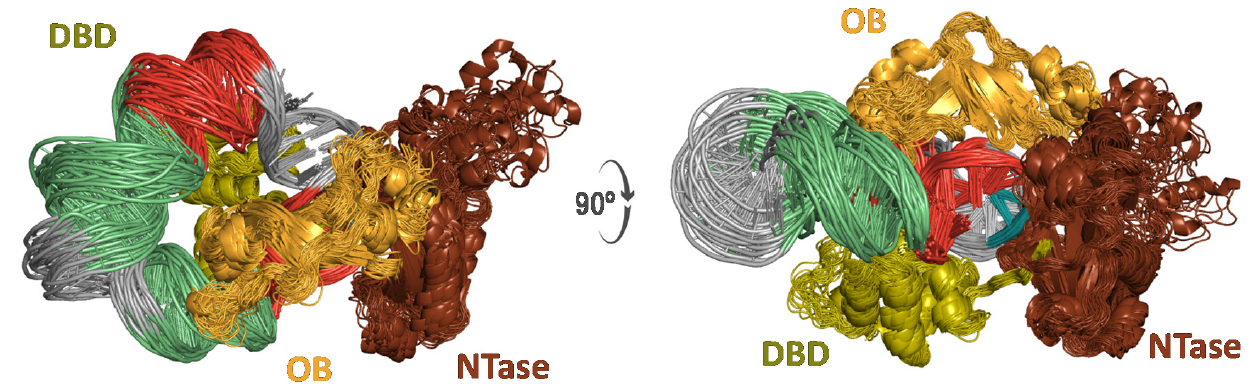
Figure 5. Cartoon representation from two viewpoints related by a 90° rotation about the X-axis (left and right) of T4 DNA ligase in complex with a 42-bp covalently closed microcircle. The T4 DNA ligase domains are labeled DBD (green), OBD (orange), and NTD (brown).